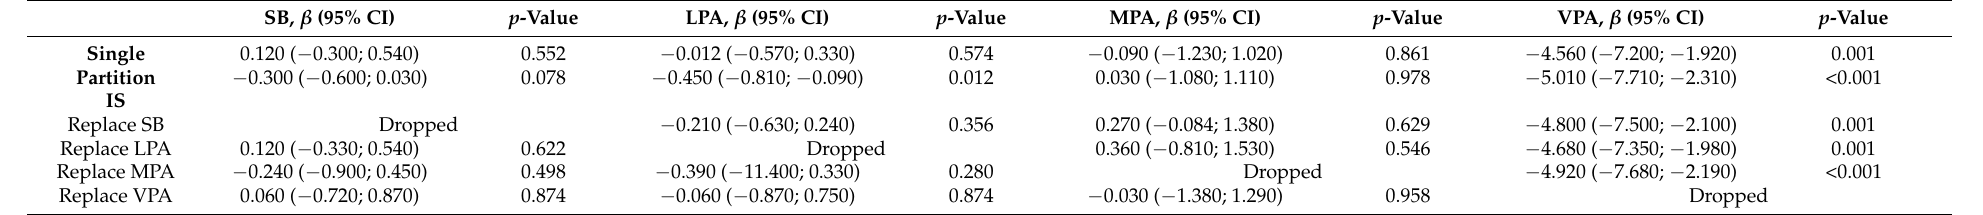
Table 2. Single, partition, and isotemporal substitution of each physical activity per 30-min/day increase and body fat mass change.